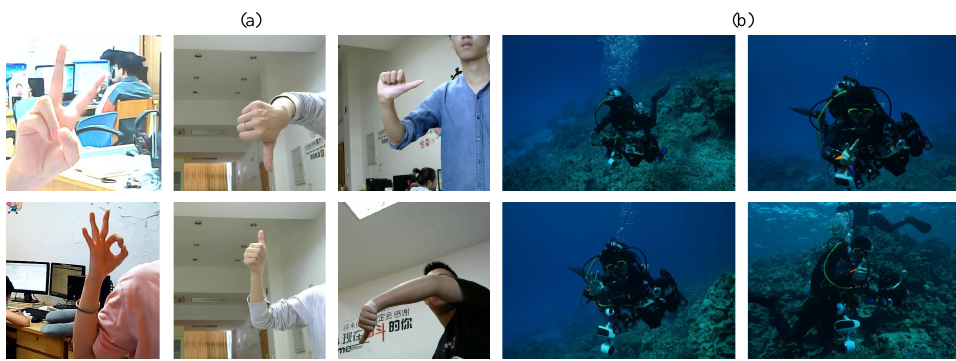
Figure 7. Display of images in the air and underwater in the gesture recognition dataset. ( a ) Air gesture dataset. ( b ) Underwater gesture dataset.